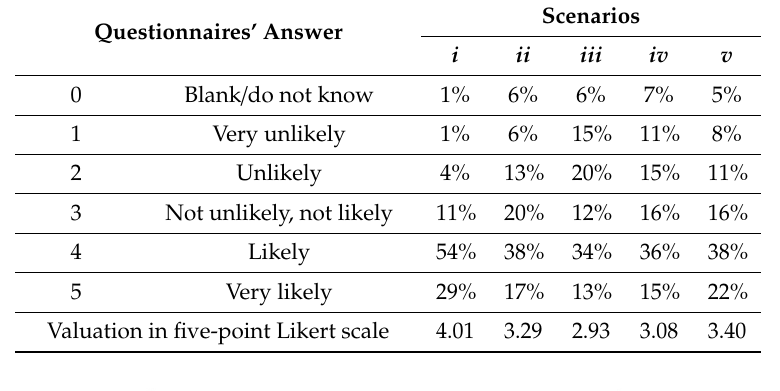
Table 7. Professional survey’s results with the participating sample.